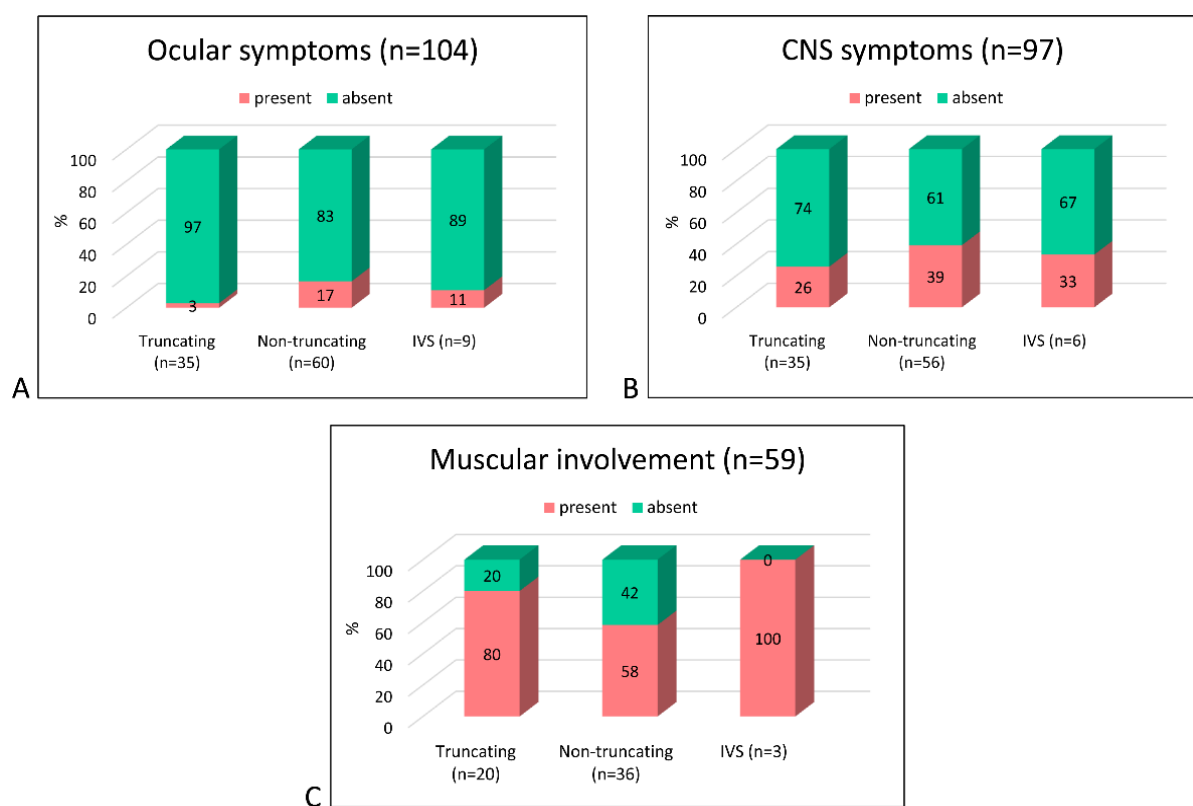
Figure 5. Extra-renal symptom distribution by type of OCRL mutation in DD2 patients. Graph bar showing the distribution of ocular ( A ), central nervous system (CNS) ( B ) and muscular ( C ) symptoms in DD2 patients.